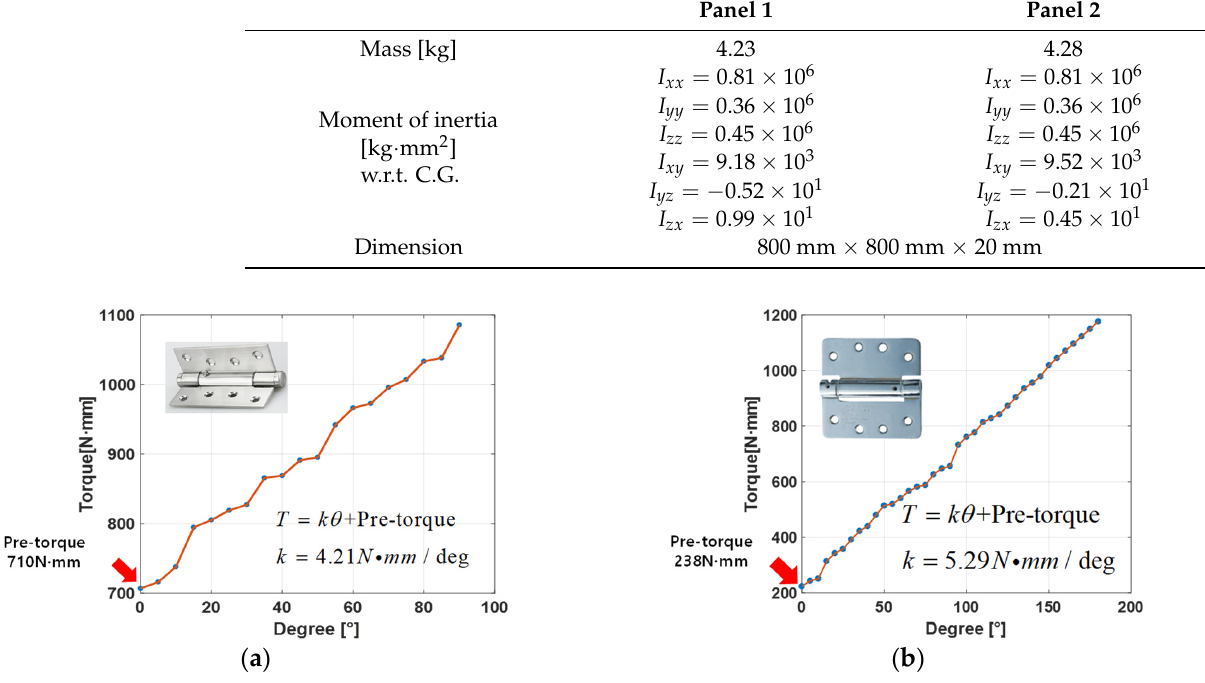
Figure 6. Configuration of rotational spring hinges and the relationship between torque and rotation angles: ( a ) 90° hinge (Joint O), ( b ) 180° hinge (Joint I).